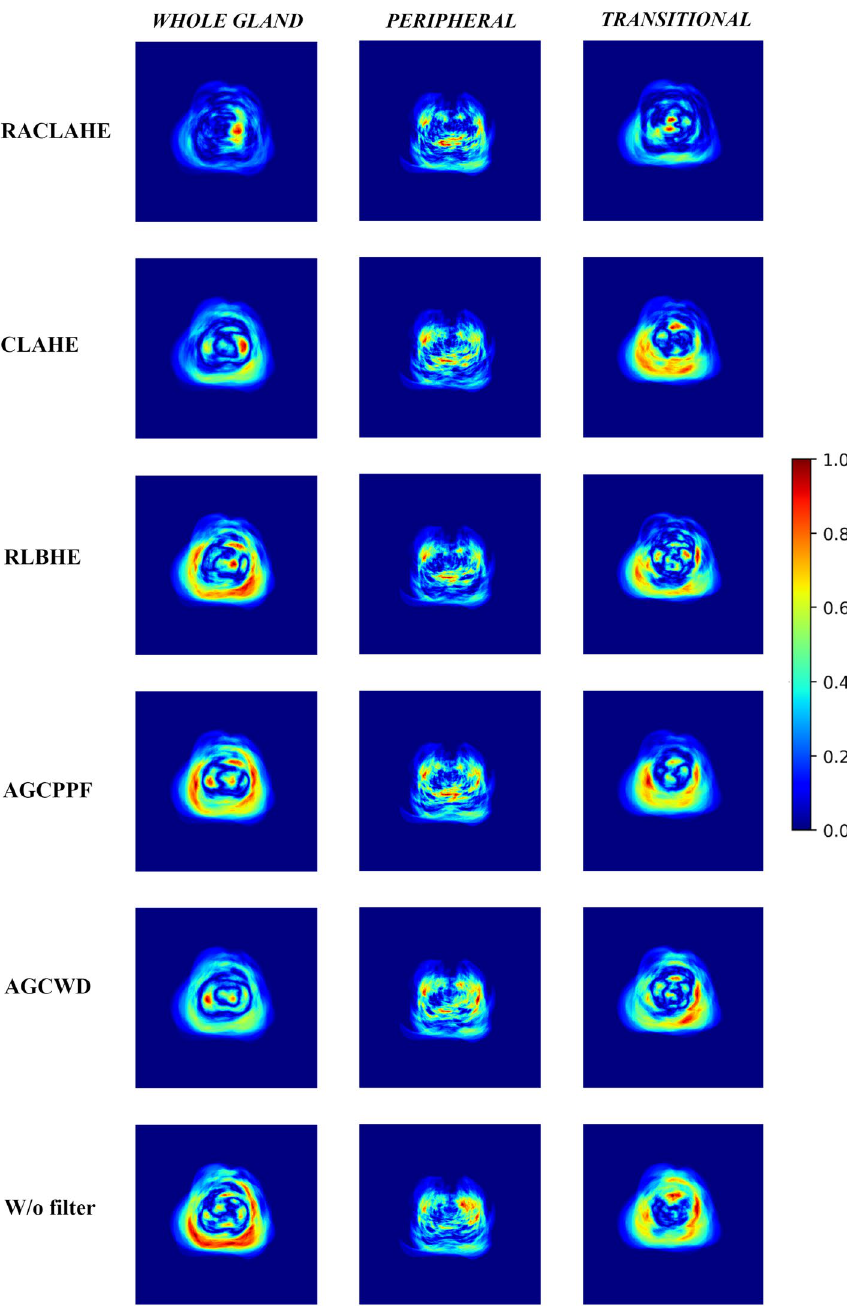
Figure 4. The visual assessment after the absolute pixel wise subtraction of GT Densitymap and FM Densitymap (Eq. 5), for each preprocessing method applied on the USE-NET